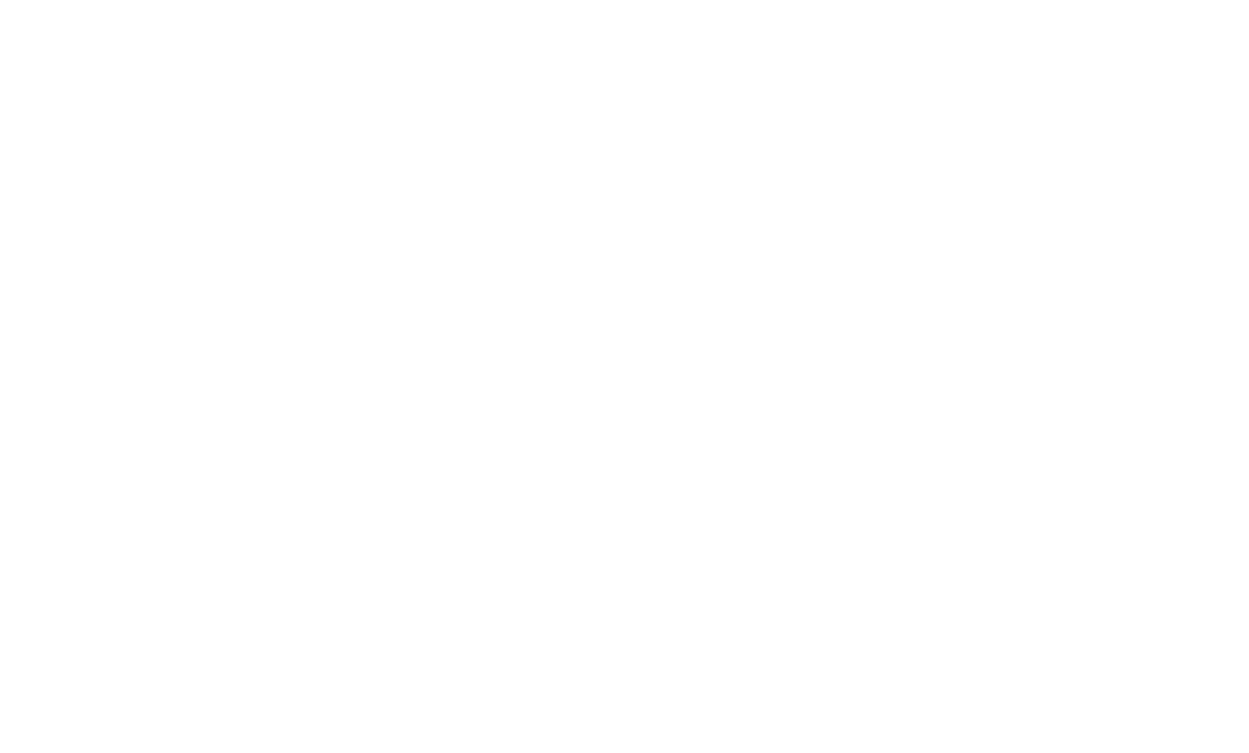
Frontiers in Aging Neuroscience | www.frontiersin.org